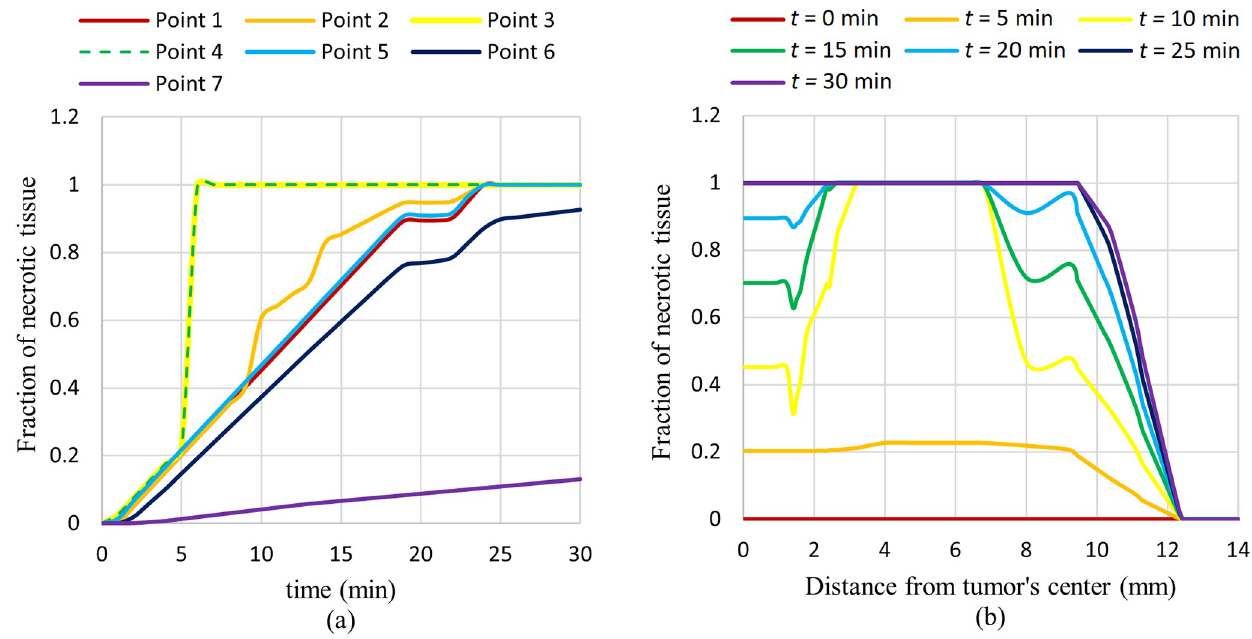
Fig 18. Fraction of necrotic tissue versus, (a) time at different considered points, (b) distance from tumor’s center at different times.